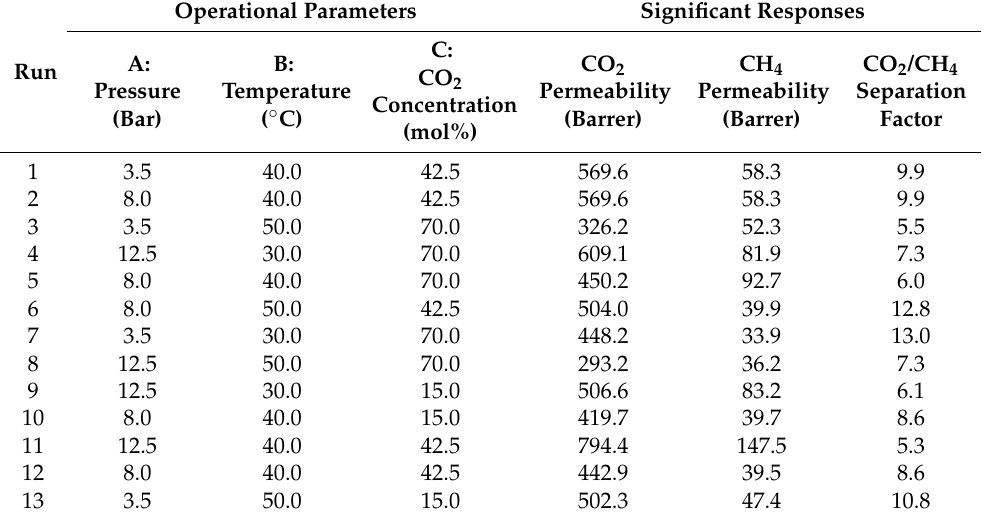
Table 2. CCD design matrix of 2 3 factorial generated by DOE and the obtained significant